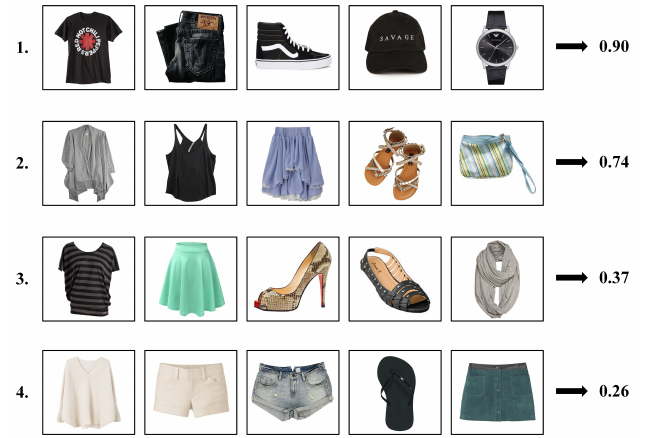
Figure 6. Results of our method in the fashion outfit compatibility prediction task. To be more intuitive, scores are normalized to be between 0 and 1.